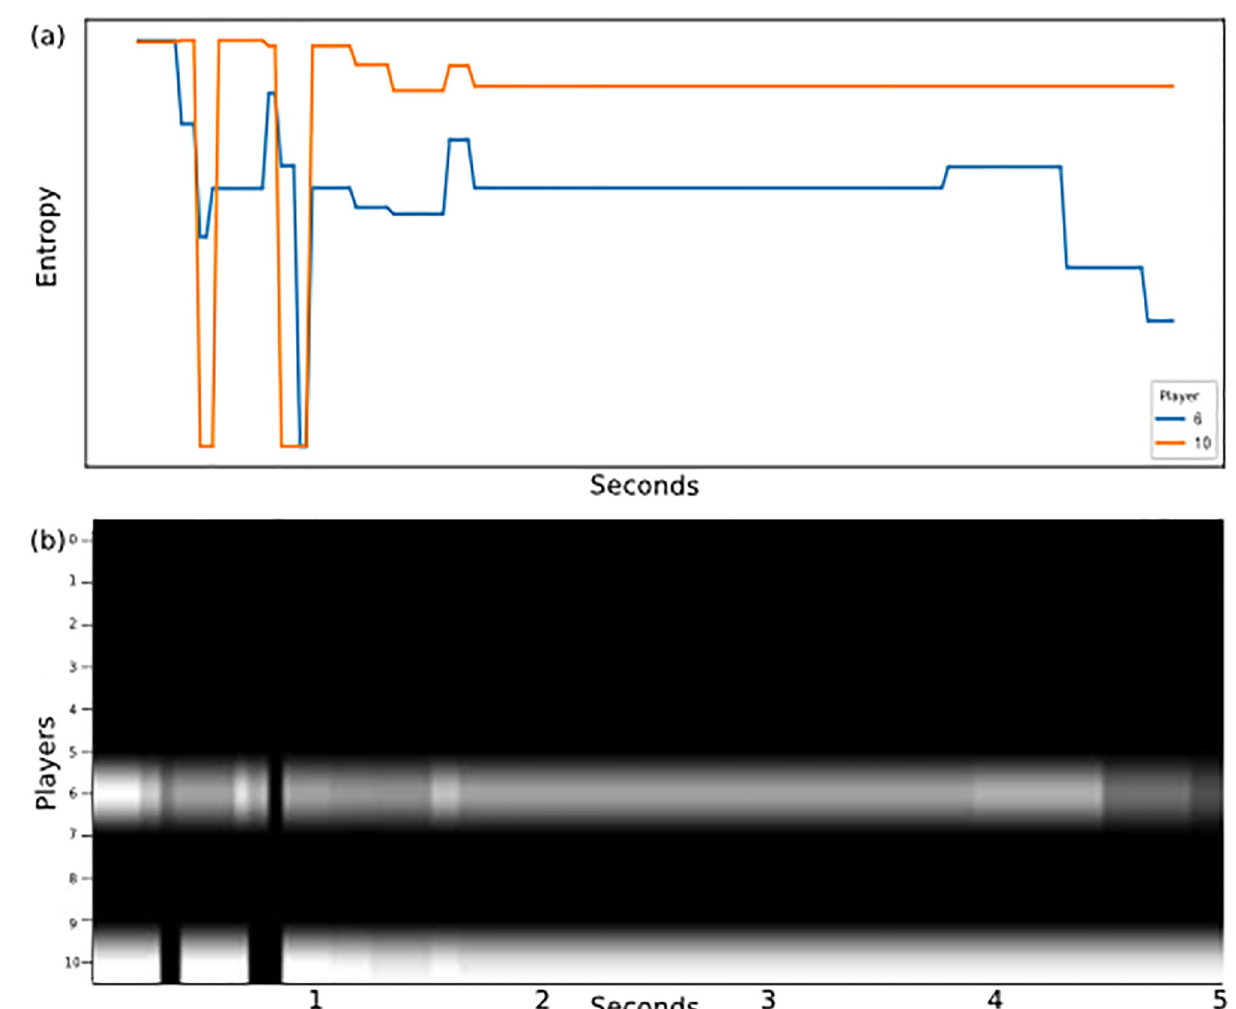
Fig 8. The figure demonstrate how the entropy values for two players vary over time, where the X axis represents the seconds of ball possession and the Y axis is the entropy measure at the moment. (b) shows the same values of item (a), but in the visual rhythm format, where light tones represent higher values of entropy and dark shades the lower